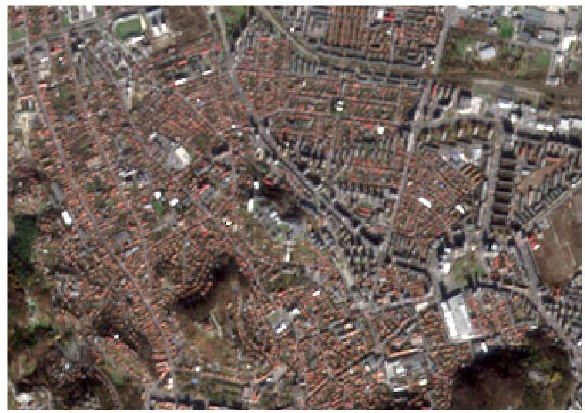
Figure 3 . Natural colour image for year